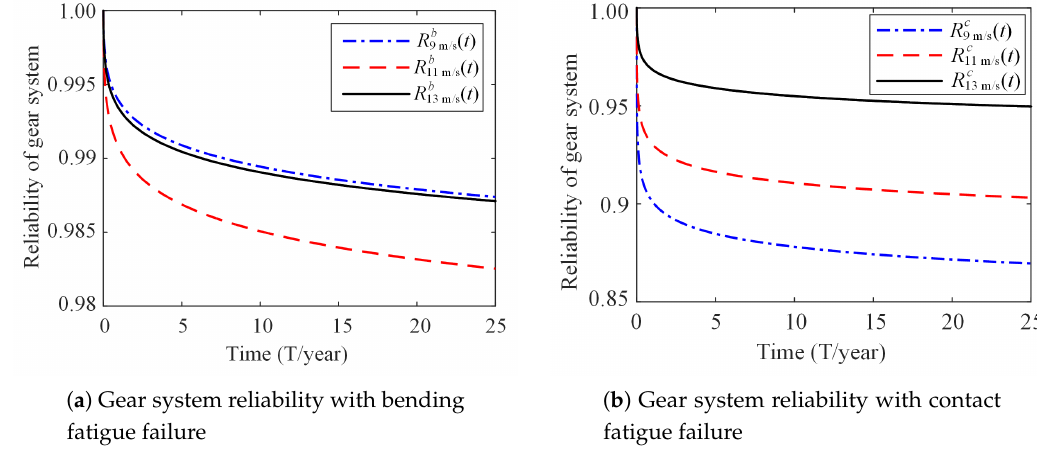
Figure 14. Reliability of gear transmission system considering different failure